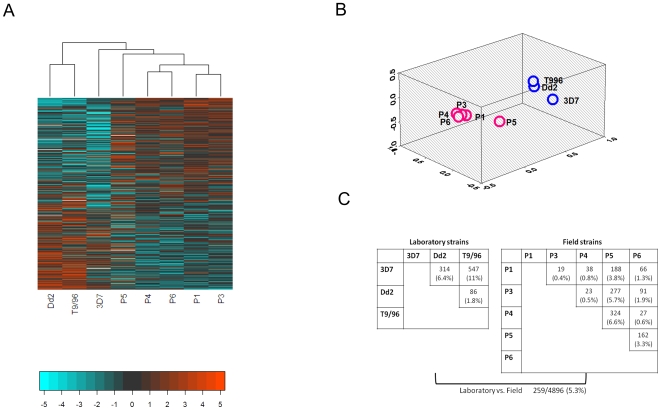
Overview of Pairwise Comparison of Transcriptional Differences between P. falciparum Laboratory and Field Strains.
A. Heat map representing each strain's (column) expression values for all genes (rows). Rows are ordered top to bottom according to the maximum difference between field and laboratory isolates. Values represented by colors (red, positive; blue, negative) are summary measures over time points (averages across the life cycle, as output from the statistical model) of the strain's log2 expression value relative to the reference material. Values are mean-normalized across rows to highlight between-strain differences. Hierarchical clustering of the column data yielded a dendrogram that broadly separated the laboratory and field strains into two clusters with 3D7 falling somewhere between these groups. B. When represented by a 3-dimensional principal coordinates plot in which distances between points indicate the degree in similarity between strains across their whole genome expression profile, laboratory and field isolates fall into two distinct clusters. C. Tests of significance revealed that 5.3% of genes were significantly differentially expressed between laboratory and field strains (>1.5-fold difference, P<0.01 after allowing for multiple testing and including genes for which the majority of probes per gene were significant). 3D7 and P5 were more different from their counterparts than other strains.